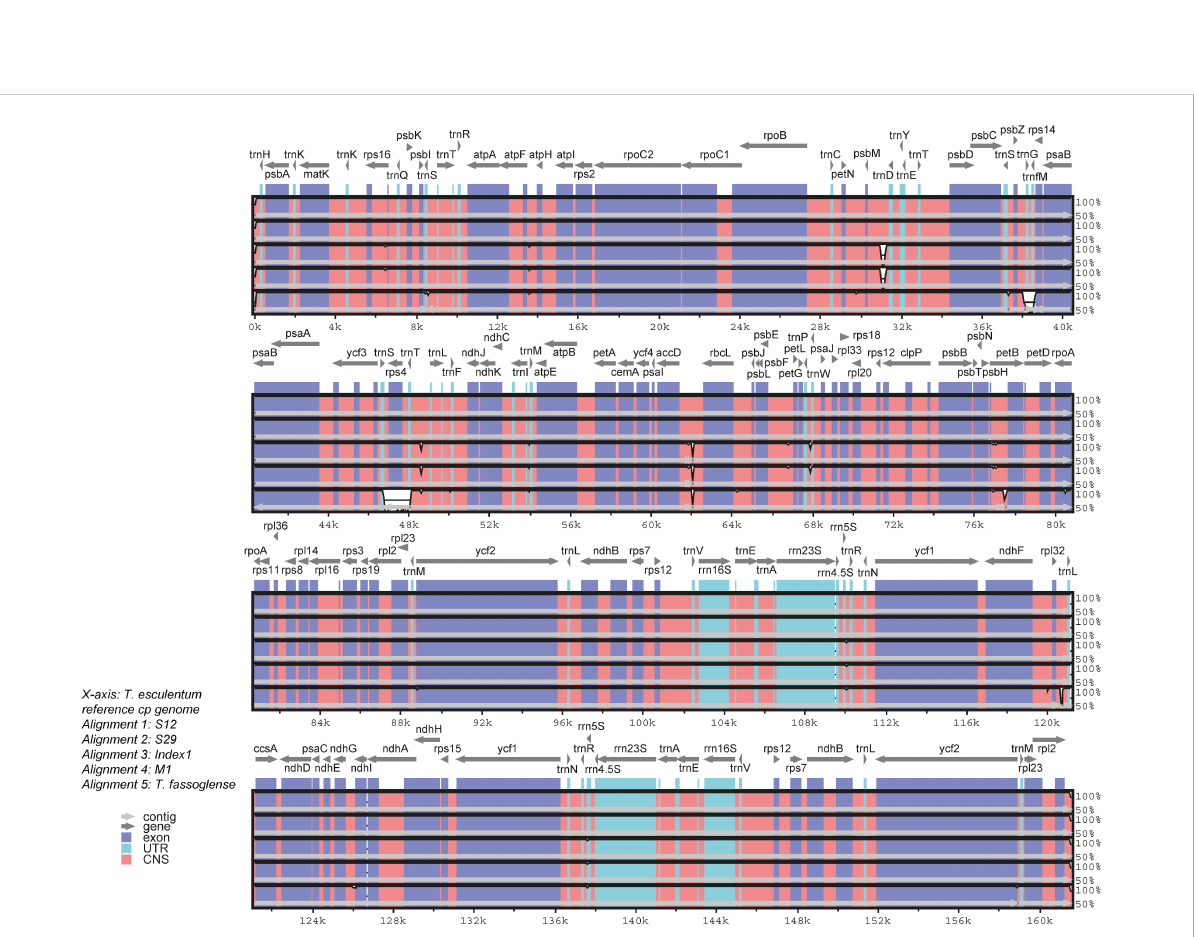
FIGURE 6 Comparison of cpDNA from four T. esculentum individuals (Type 1: S12 and S29, and Type 2: Index1 and M1) and the related species T. fassoglense (NC_037767.1) by mVISTA Shuf fl e-LAGAN alignment. The plastome of T. esculentum (KX792933.1) was used as the reference. White blanks indicate regions of sequence divergence. The x -axis represents the position in the chloroplast DNA. The y -axis shows the similarity of sequence alignment, ranging from 50% to 100%. The location and transcription direction of the cp gene are labeled at the top of the block. Conserved exons, introns and noncoding regions are marked on the graph with different